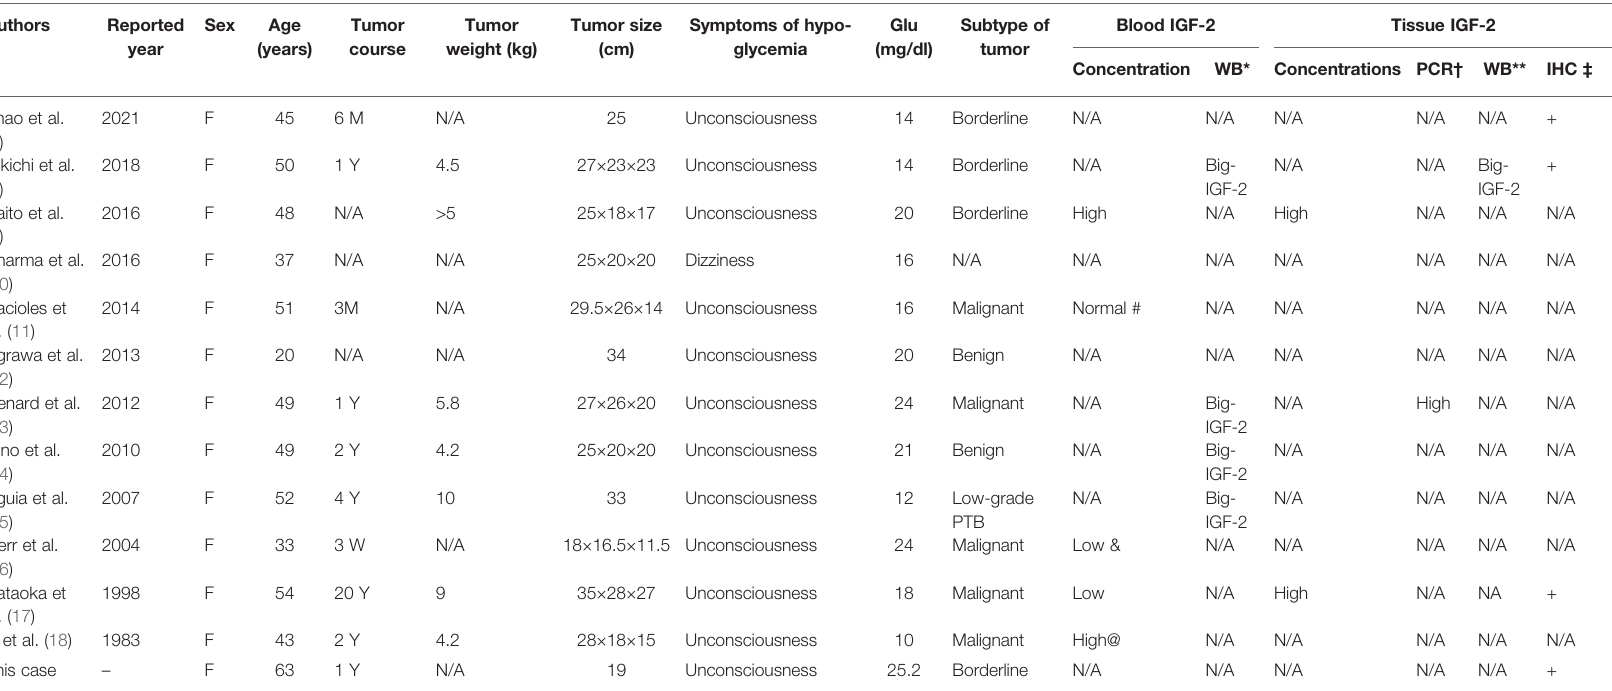
TABLE 1 | Characteristics of reviewed reports of non-islet cell tumor hypoglycemia due to phyllodes tumor of breast.